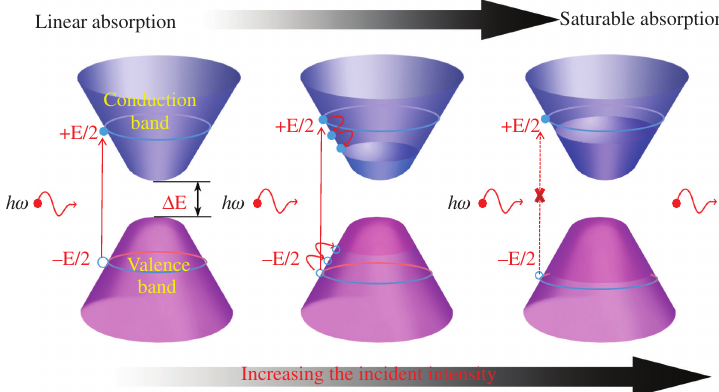
Figure 6: Saturable absorption mechanism of PdSe